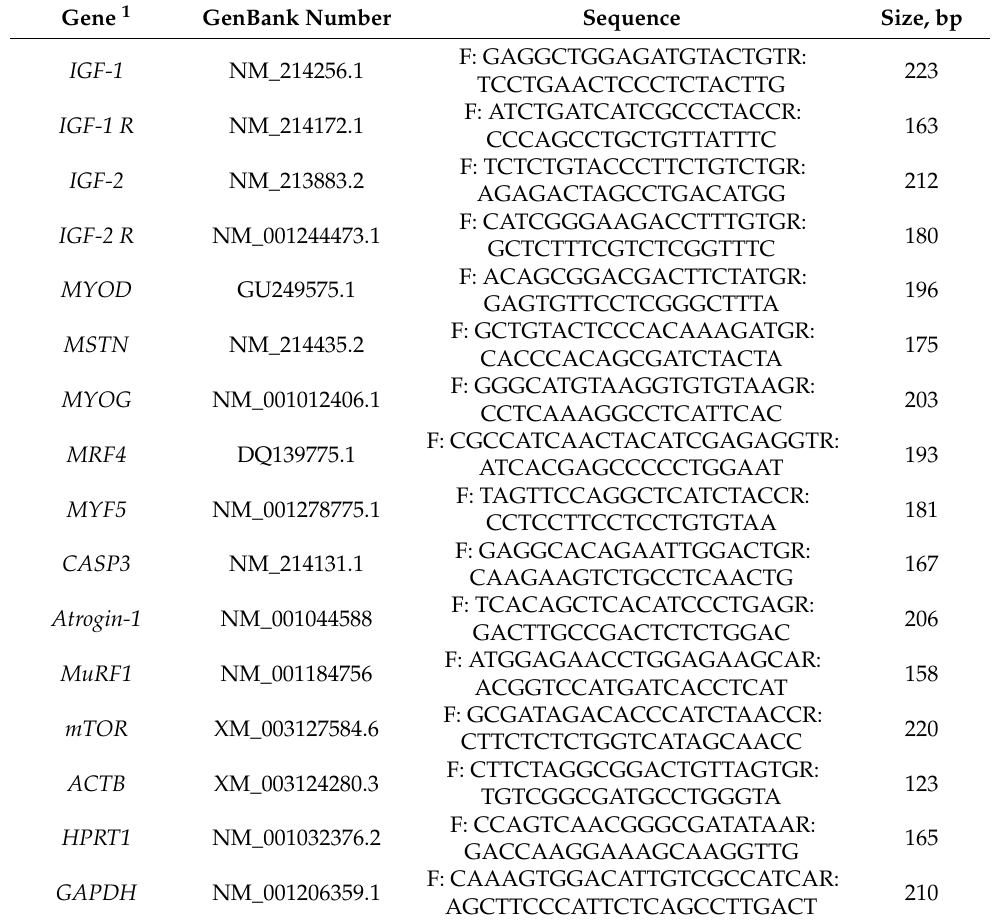
Table 2. Oligonucleotides used on gene expression